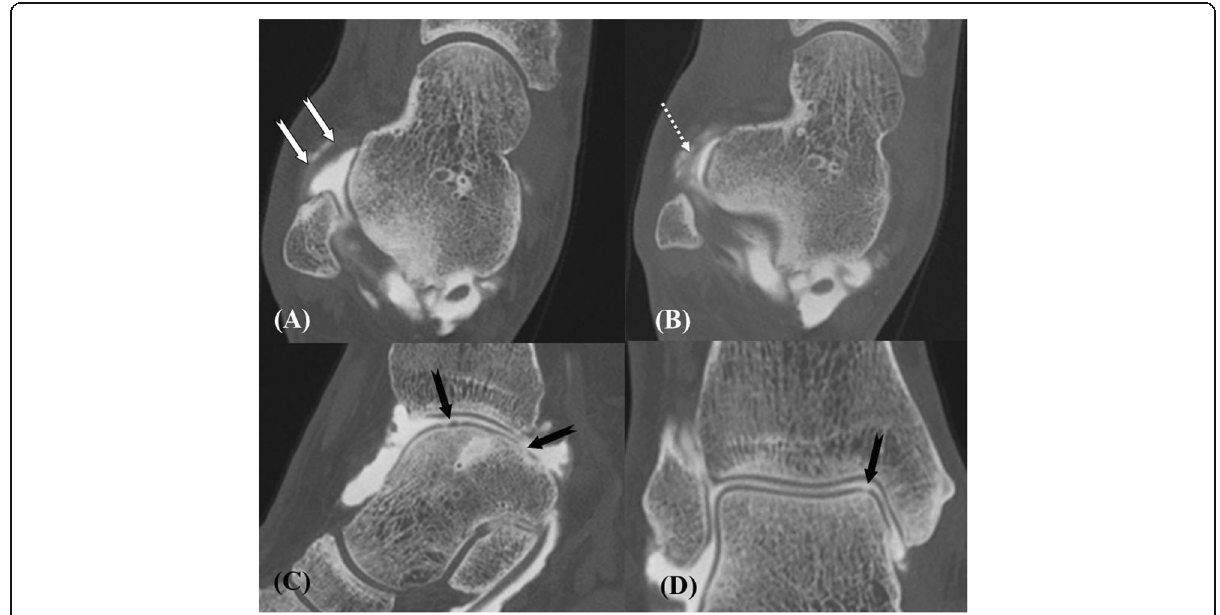
Fig. 3 Right chronic predominately medial ankle pain after multiple episodes of sprains, and the current episode was lateral sprain. Axial CTA images through the talar neck ( a , b ) demonstrate lateral bowing of the ATFL, with loss of normal taut appearance (solid arrows), note thinning of the ligament proximally, also note fraying of its distal band (dashed arrow). Sagittal ( c ) and coronal ( d ) CTA show cartilage defects through medial and posterior aspects of the talar dome (black arrows) with variable thickness affection, note intact subchondral bone plate and lack of osseous injury. Note also uneven joint space widened anteriorly